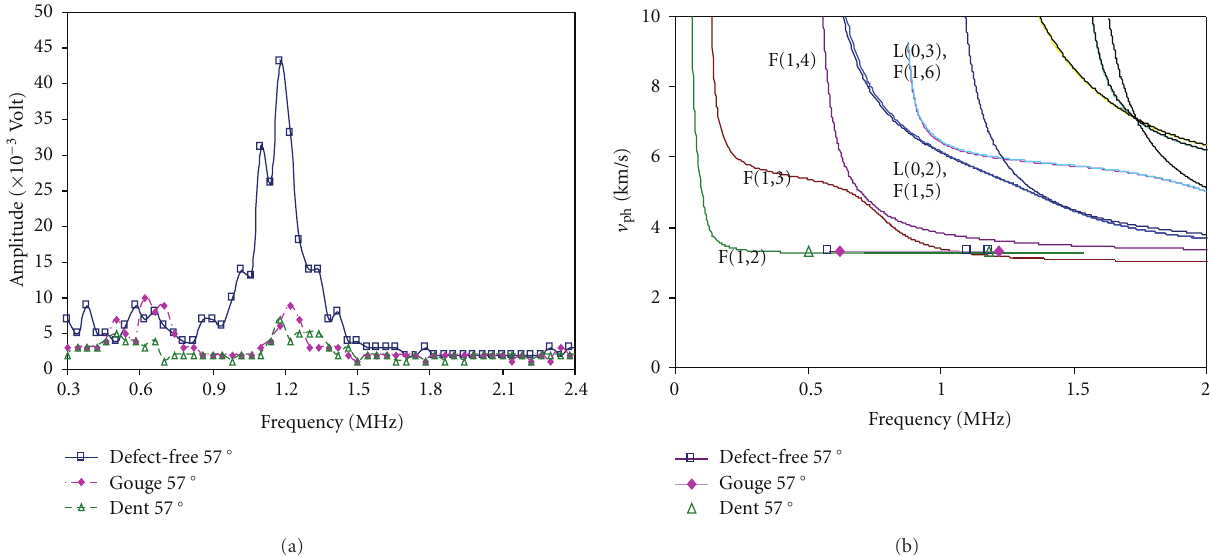
Figure 3: (a) experimental V ( f ) curves for defect-free and defective pipes when water flows through the pipes at 57 ◦ incident angle for defective and defect free pipes, (b) theoretical phase velocity dispersion curves obtained for a steel pipe with experimentally obtained phase velocities for modes generating at 57 ◦ incident angle.